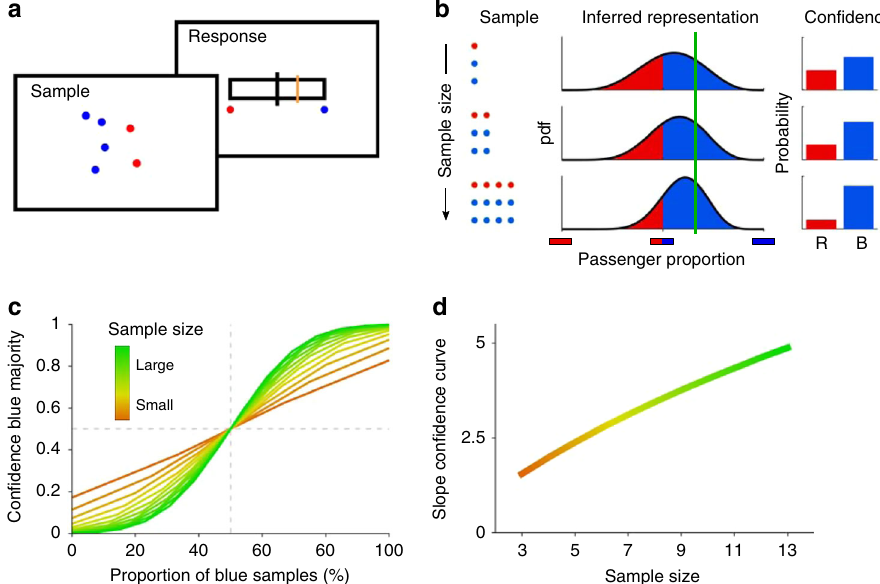
Fig. 1 Posterior-based con fi dence features sample size effects a Task: The colored dots (sample) represent two kinds of passengers (blue and red) that disembarked a very large airplane. The participants are subsequently asked to report the con fi dence in their decision that the airplane carried more blue or red passengers (blue majority) by horizontally moving the cursor line (orange). In this case, because the sample suggests a blue majority, the response cursor should be on the right. b Sample size increases posterior-based con fi dence in a blue majority suggested by the blue majority of the sample. Con fi dence (right) is computed as expected accuracy from the area under the curve for the inferred proportion (middle) from the observed sample (left). Although the proportion of blue passengers (green line, middle) is the same for all three samples (rows), the inferred distribution depends on sample size. The larger the con fi dence, the closer the response line on the previous panel should be to the rightmost border. c Con fi dence in blue majority should increase with the proportion (%) of blue samples for all sample sizes, but it does so with a higher slope for larger sample sizes (color coded). d Consequently, the slope parameter of fi tted sigmoidal functions increases with sample